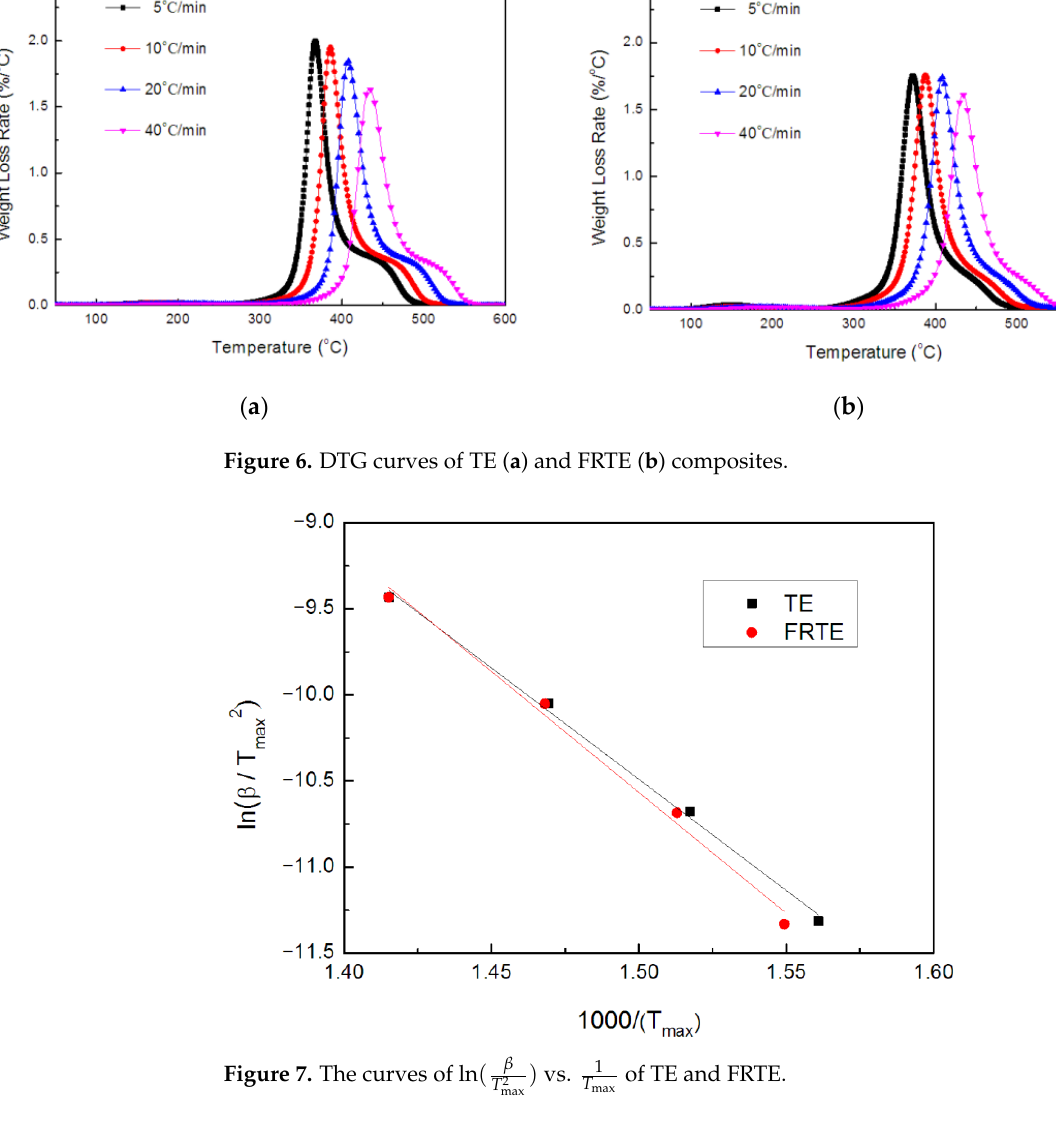
) vs. 1 of TE and T max T 2 max